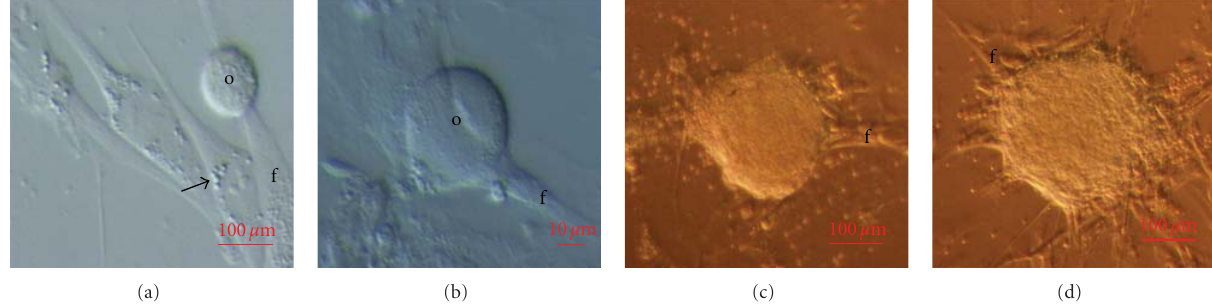
Figure 6: In vitro culture of cells scraped from the ovarian surface epithelium. (a) Oocyte-like cell developed in vitro on autologous ovarian fibroblasts and small round cells (arrow) with diameters of 2 to 4 μ m proliferating in the surroundings as attached to fibroblasts on day 4 of the culture (magnification 100-times). (b) Oocyte-like cell developed in vitro on autologous ovarian fibroblasts on day 10 of the culture (magnification 200-times). (c, d) Cell clusters developed in vitro on autologous ovarian fibroblasts on day 4 of the culture (magnification 100-times). (Inverted microscope, Ho ff man illumination.) f: autologous ovarian fibroblast, o: oocyte-like